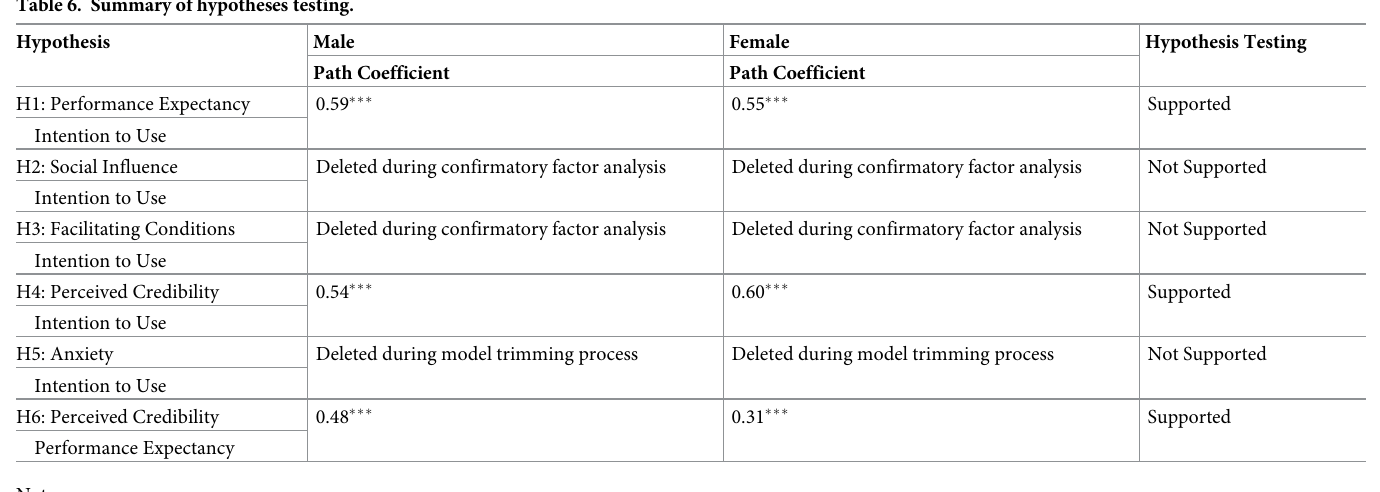
Table 6. Summary of hypotheses